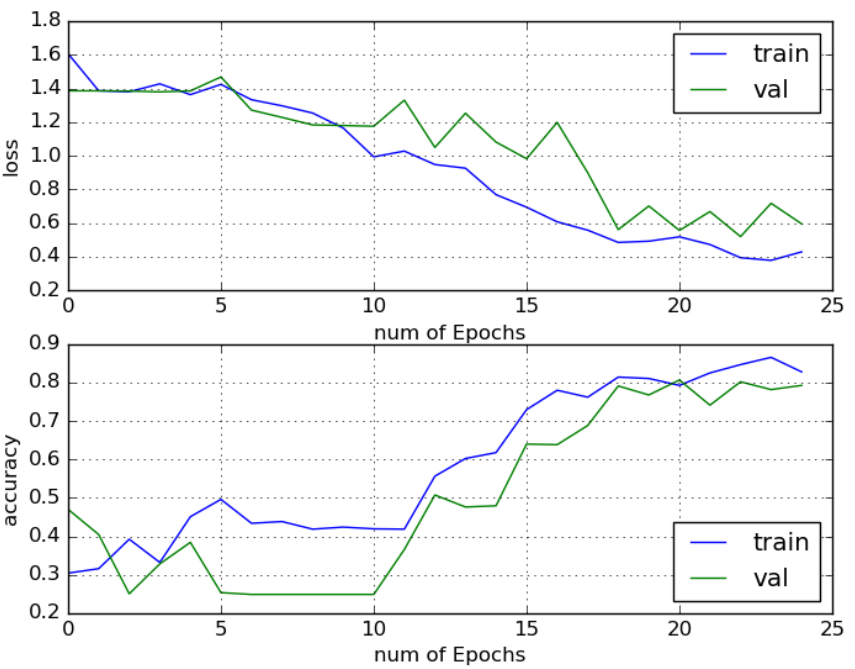
Figure 5. VGG-16 fine tune model on MLe2e using RMSprop